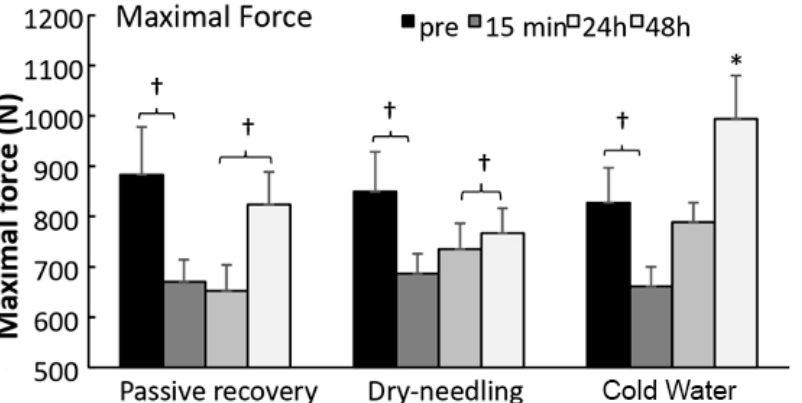
Figure 2. Maximal isometric force measured in the bench press before and after 15 min, 2 h, 24 h, and 48 h after an exercise induces muscle damage and a recovery (passive, dry-needling, or cold-water immersion) protocol after 15 min, 24 h, and 48 h after exercise-induced muscle damage and a recovery protocol. * indicates a significant difference with all other test moments ( p < 0.05). † indicates a significant difference between these two test moments ( p < 0.05).